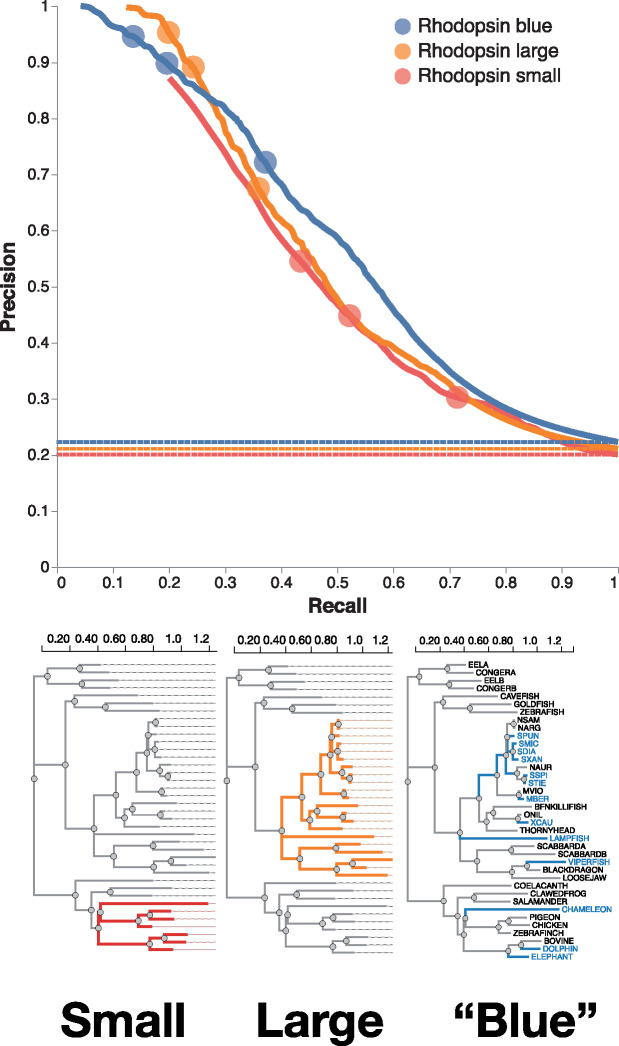
Contrast-FEL performance on vertebrate rhodopsin simulations. Precision–recall curves for the three sets of simulations, all based on the vertebrate rhodopsin tree from Yokoyama et al. (2008), with different choices for the “test” branch set (precision = true positives/all test positives, recall = true positives/positive training cases). Dotted lines show corresponding base rates for “no-skill” classifiers in each case (i.e., classify all sites as differentially selected). Circles on the individual curves show (left-to-right) precision–recall values for q=0.1,q=0.2,q=0.5. There were a total of 37,565 variable sites for the “small” case, 15,010 sites for the “large” case, and 37,401 sites for the “blue” case.